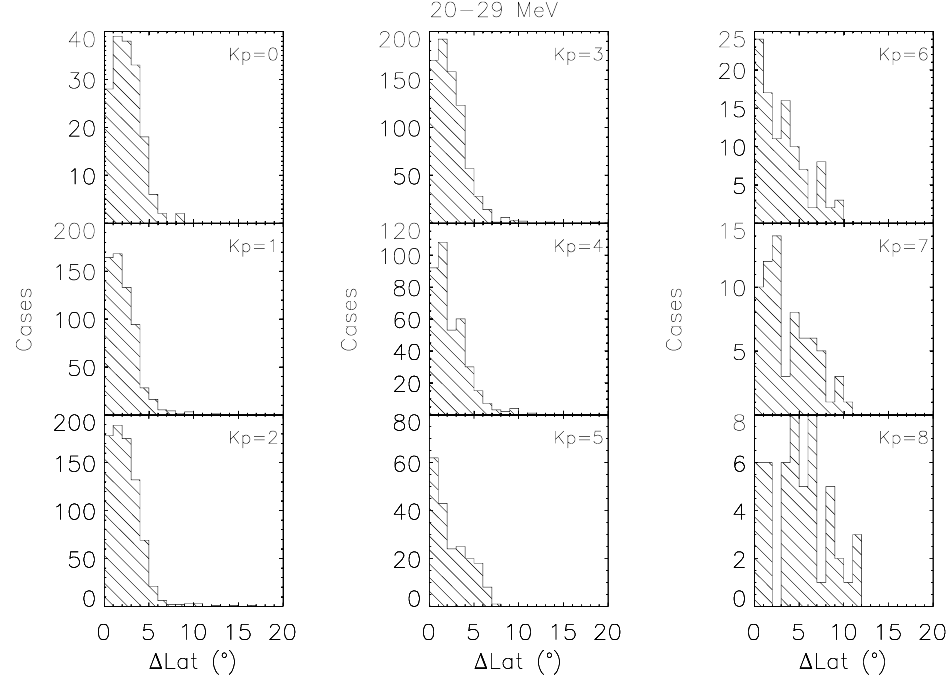
Fig. 4. Histograms of numbers of cases of 1 Lat for 20–29MeV protons and the Tsyganenko model binned by K p